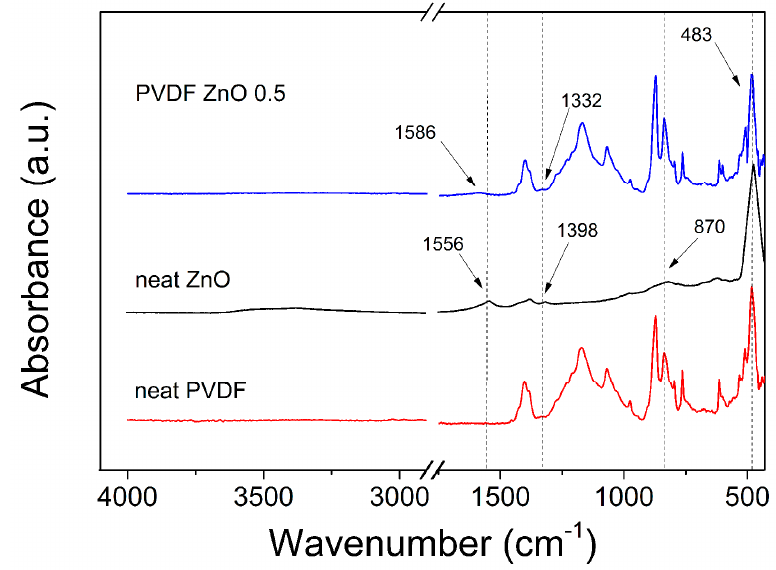
Figure 4. Fourier-Transform infrared (FTIR) spectra for ZnO particles (black) and spin-coated films of neat PVDF (red) and PVDF/ZnO 0.5 composite (blue).